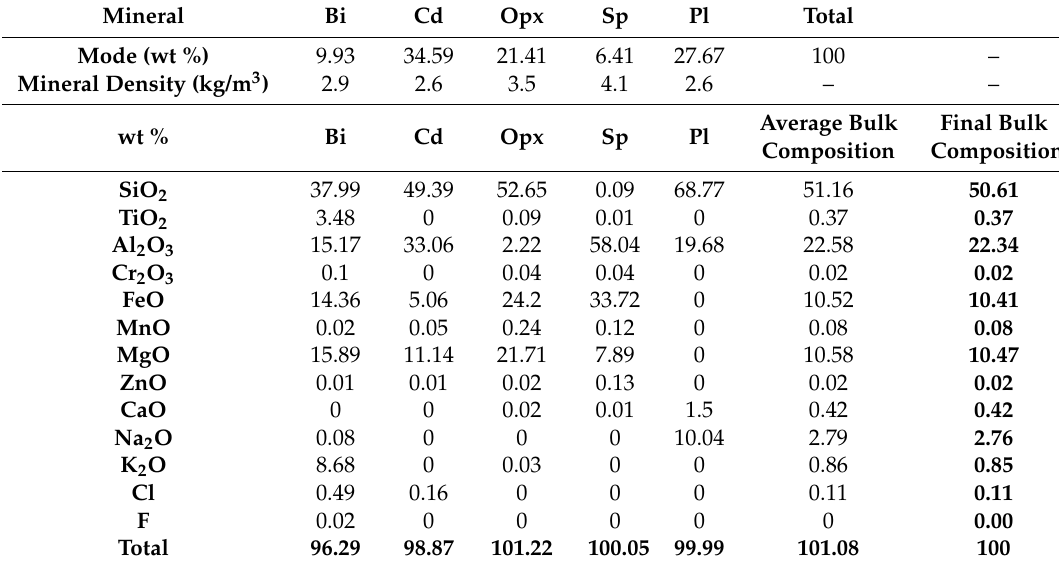
Table 1. Mineral modal proportions and average mineral chemistry used to obtain a chemical composition of the orthopyroxene-bearing domains for the purposes of phase equilibria modelling. Individual mineral analyses can be found in Supplementary